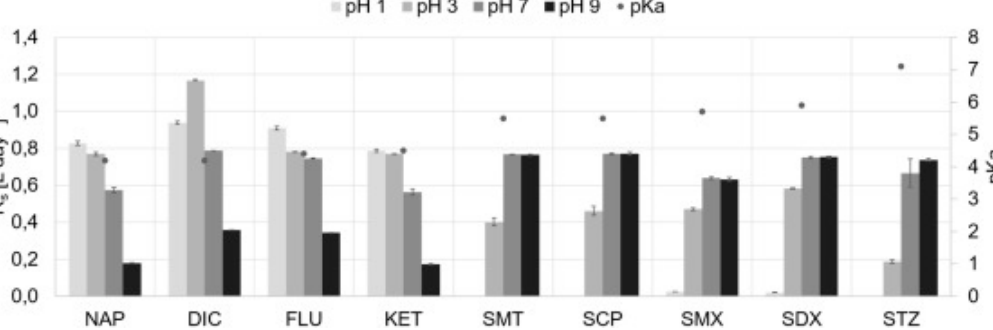
Figure 6. Dependency between sampling rate (Rs) values and the salinity of the donor solution for selected sulfonamides and NSAIDs (the pKa values of target compounds are specified by the black dots). Figure adopted from the reference [138] with copyright permission.